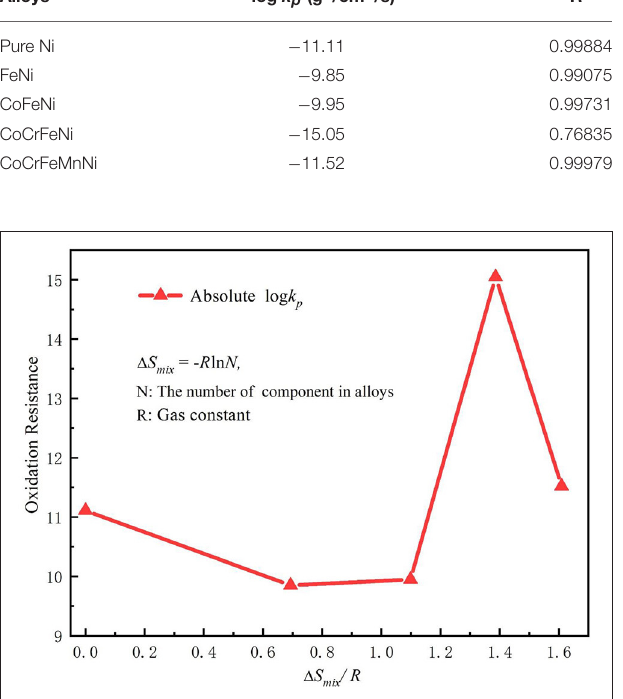
FIGURE 4 | The oxidation resistance as a function of the mixing